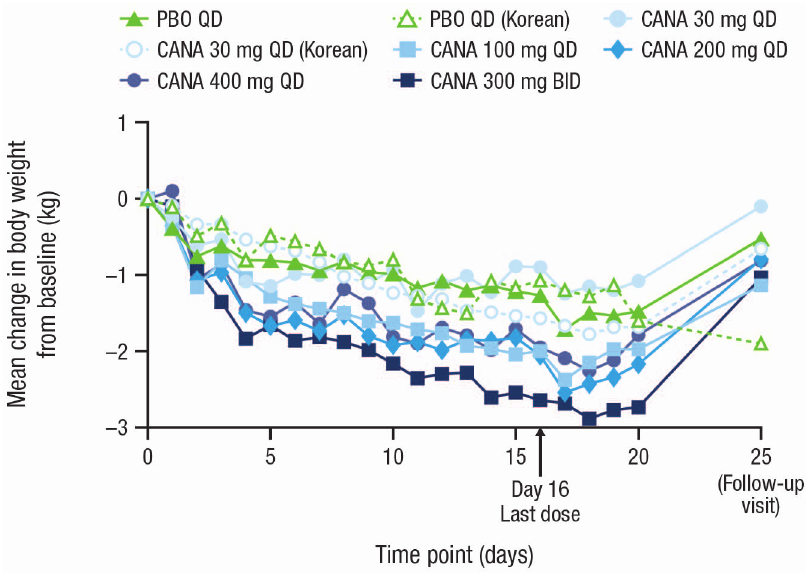
Figure 6. Mean change in body weight with daily canagliflozin treatment. PBO, placebo; CANA, canagliflozin; QD, once daily; BID, twice daily.